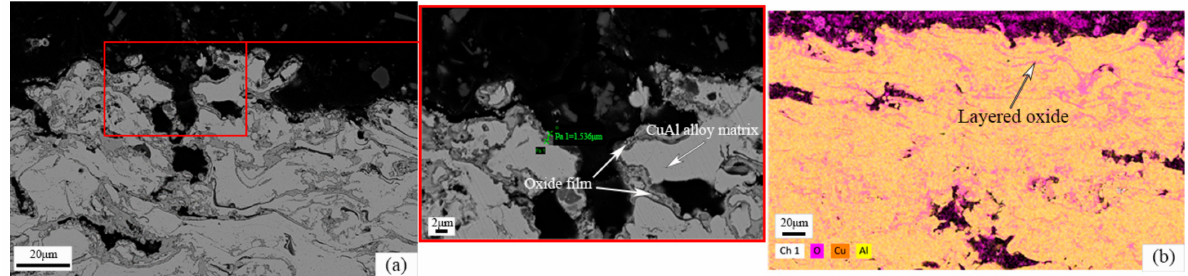
Figure 5. ( a ) Micromorphology of the coating after static oxidation at 500 ◦ C for 100 h; ( b ) element distribution in